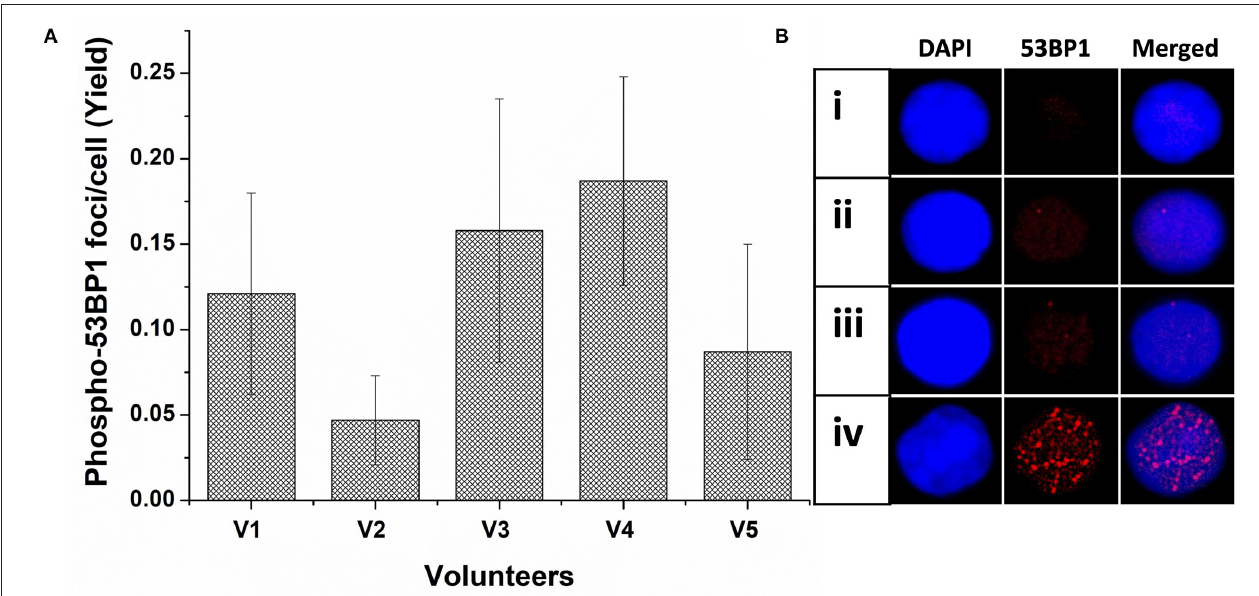
FIGURE 1 | (A) Spontaneous frequency of phospho-53BP1 foci in non-stimulated and unirradiated PBLs of five volunteers (V1-V5). Error bars signify SD (5 × 3 i.e., five individuals with triplicate blood sampling). More than 300 PBLs were analyzed for estimating the spontaneous frequency of phospho-53BP1 in each volunteer. (B) Representative PBLs with (i) no foci (ii) one focus (iii) two foci (iv) numerous foci (could be apoptotic cell).